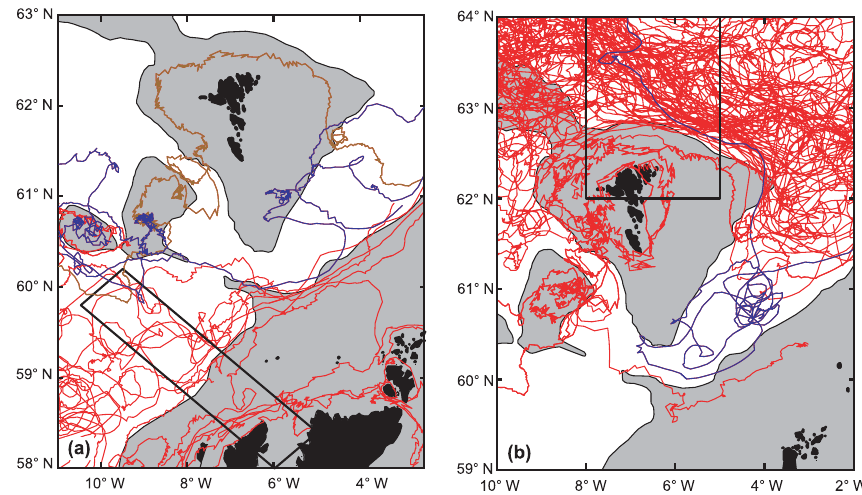
Figure 8. Tracks of 104 surface drifters passing through or close to the Faroese Channels. (a) Tracks of 16 surface drifters that entered the polygon shown southwest of the Wyville Thomson Ridge. (b) Tracks of 89 drifters that entered the rectangle shown north of the Faroes (extended northwards to 66 ◦